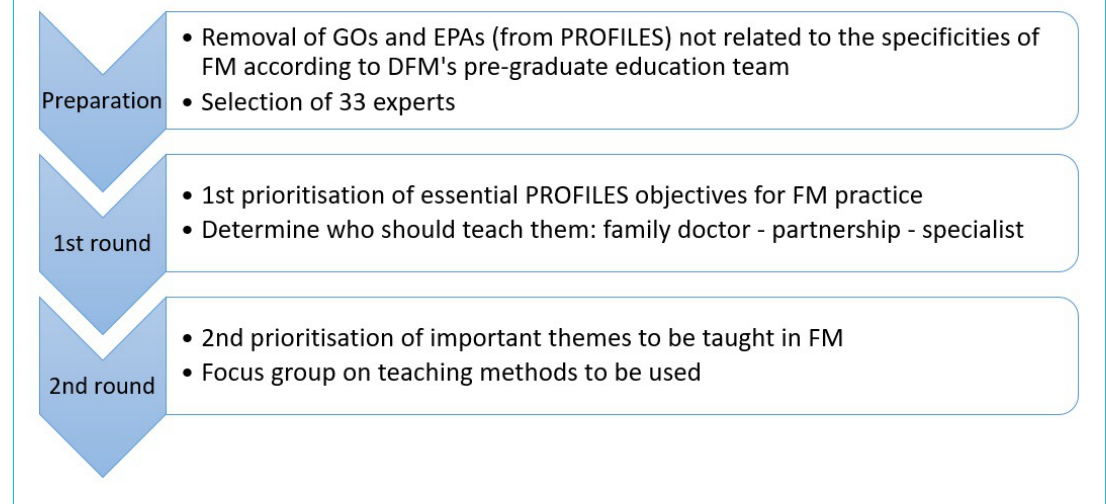
Figure 2: Prioritisation of family medicine teaching according to a modified Delphi method.